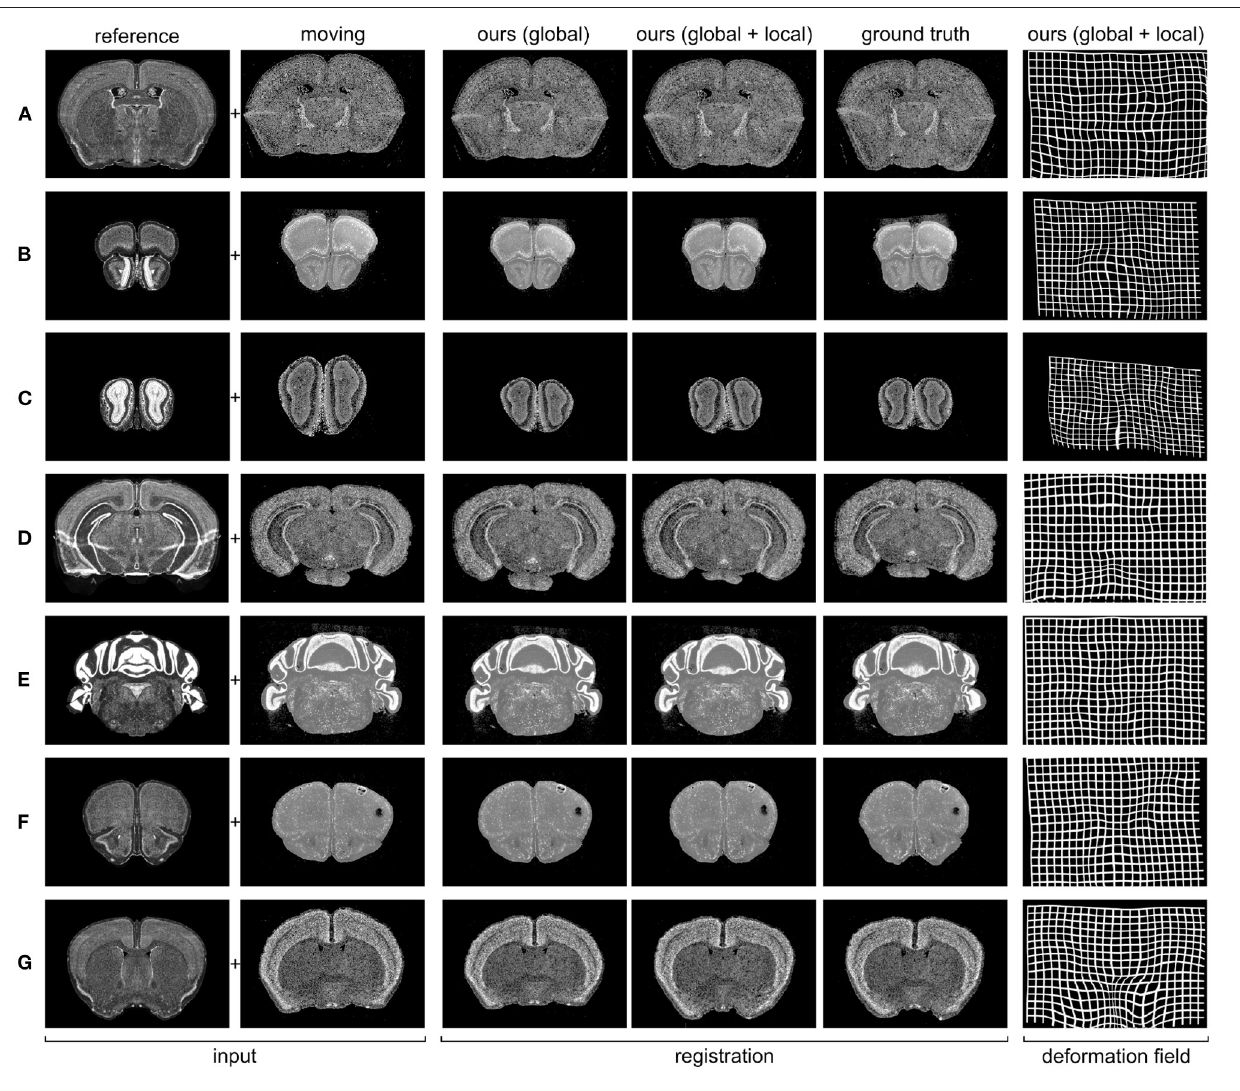
FIGURE 3 | Predicted registrations on slices from the 7 different gene expression atlases used in our experiments (see section 2.4 for details). (A) PVALB gene, section 236; (B) CALB1 gene, section 100; (C) NPY gene, section 52; (D) SST gene, section 328; (E) CALB2 gene, section 451; (F) VIP gene, section 129; (G) CCK gene, section